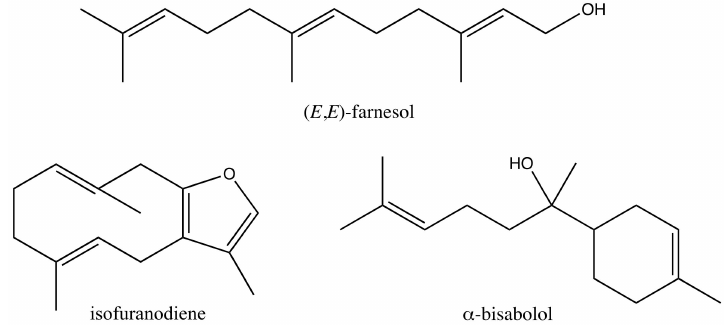
Figure 1. Chemical structures of the sesquiterpenes tested on Echinococcus granulosus